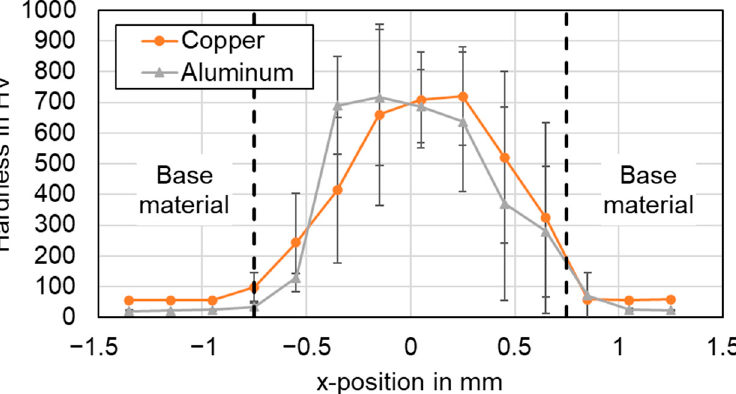
Figure 22. Microhardness profiles of the weld seam produced with vertical eight beam oscillation using parameter set #6 ( n = 4).